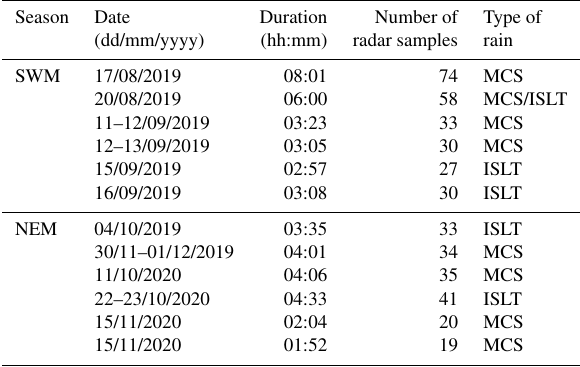
Table 5. Details of rain events (date, duration, number of radar sam- ples within the event and type of event) used for the assessment of four DSD